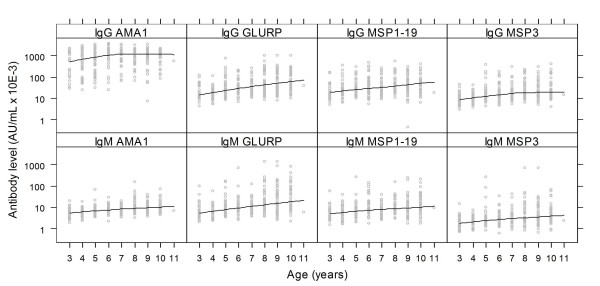
Baseline IgG and IgM levels in relation to age. The top and bottom panels represents total IgG or IgM levels to AMA1, GLURP, MSP119 and MSP3 in relation to age of Ghanaian children, respectively. The line shows the LOESS smoothed estimate of the geometric mean.